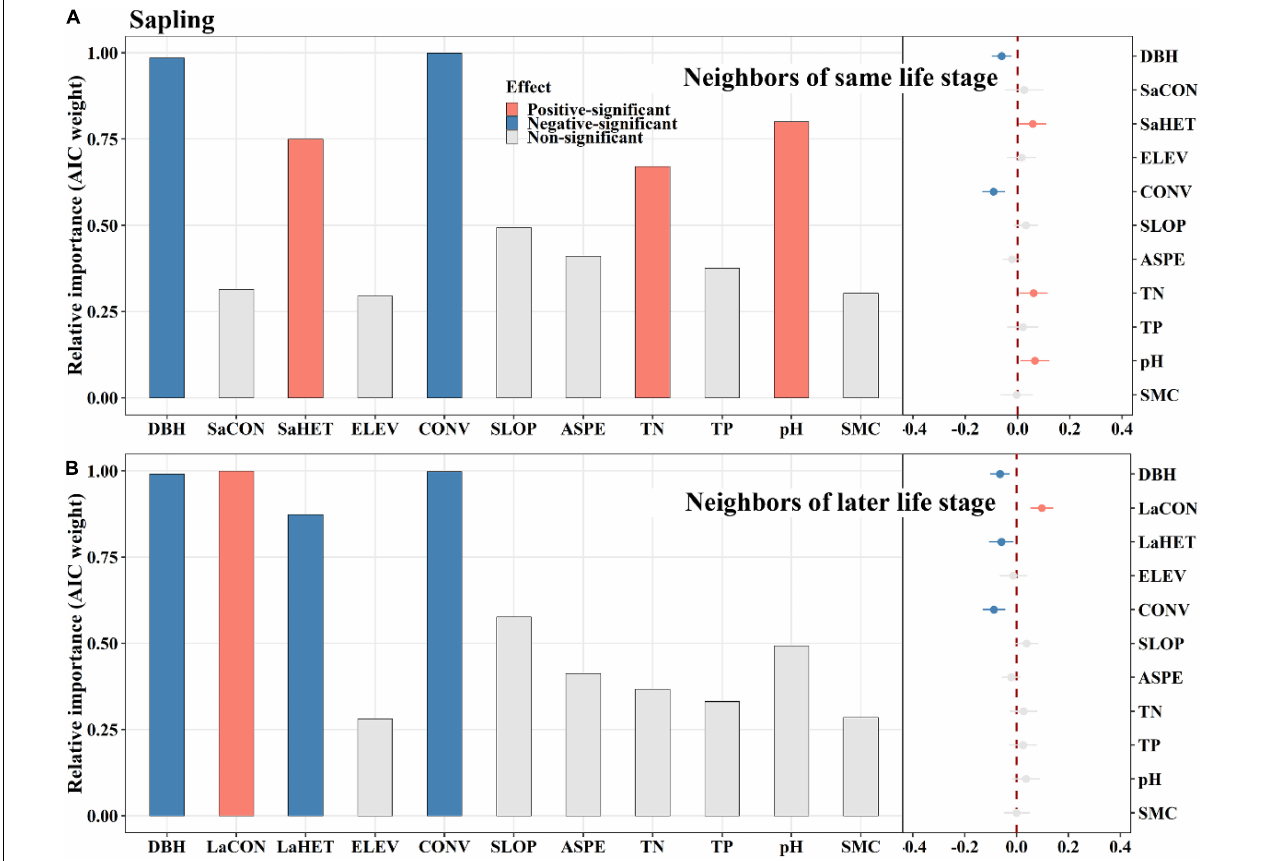
FIGURE 4 | The relative influence of potential variables including neighbors of same life stage (A) or neighbors of later life stage (B) on sapling mortality. The variables examined are the log-transformed initial DBH of tree (DBH), conspecific neighborhood index at the same life stage (SaCON), conspecific neighborhood index at the later life stage (LaCON), heterospecific neighborhood index at the same life stage (SaHET), heterospecific neighborhood index at the later life stage indicates (LaHET), elevation (ELEV), slope (SLOP), aspect (ASPE), convexity (CONV), total nitrogen (TN), total phosphorus (TP), pH value (pH) and moisture content (SMC) of ∧ ∧ β j ). Blue and red points indicate that parameter estimates differ significantly from zero at the soil. Error bars represent 1.96 s . e . j around the model-average estimator ( level of alpha =